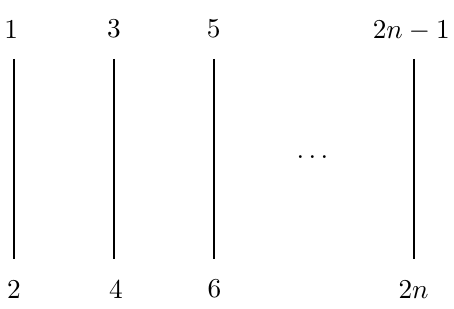
Figure 1 . The set on which S n [ S 2 ] acts. A group element can permute the n pairs, while switching or not switching each individual